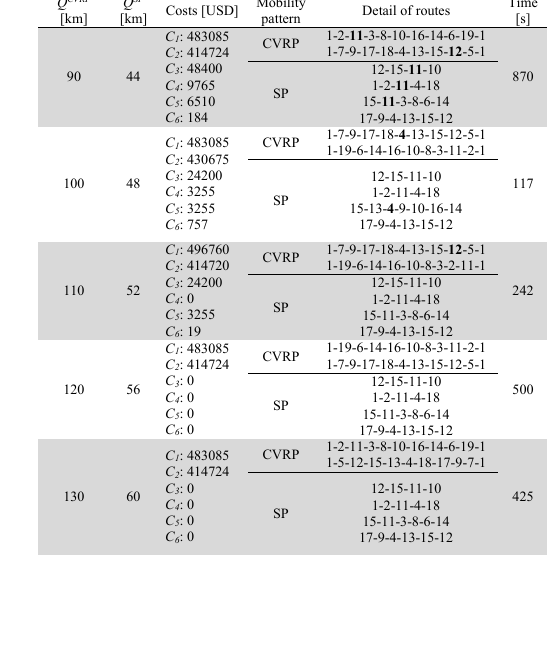
Results for Pn19k2-IEEE34 with non-linearized mathematical model Q